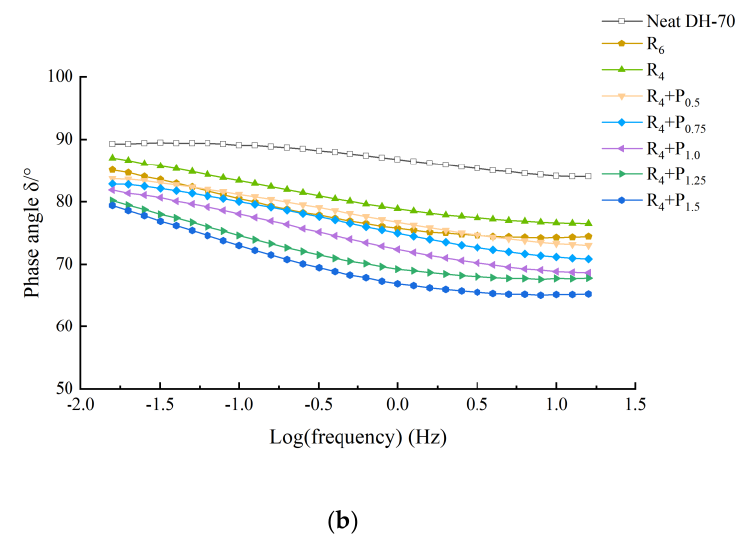
Figure 7. Complex modulus and phase angle master of compound PPA – SBR modified binders of DH – 70# asphalt: ( a ) Complex modulus-Log(frequency) results; ( b ) Phase angle-Log(frequency) results.